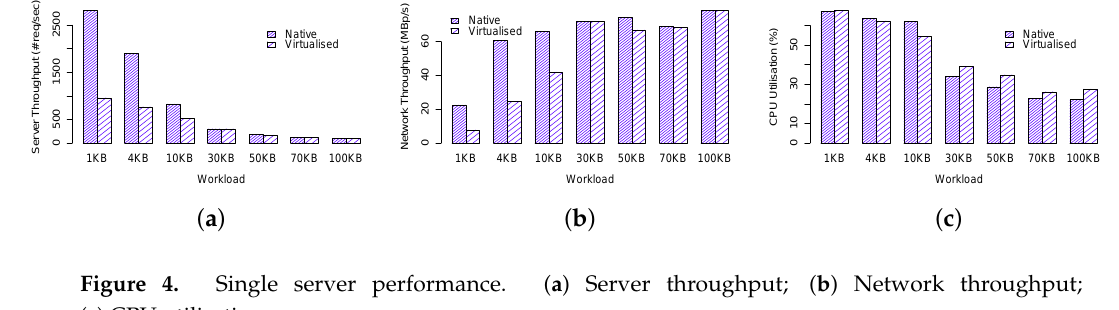
Figure 4. Single server performance. ( a ) Server throughput; ( b ) Network throughput; ( c ) CPU